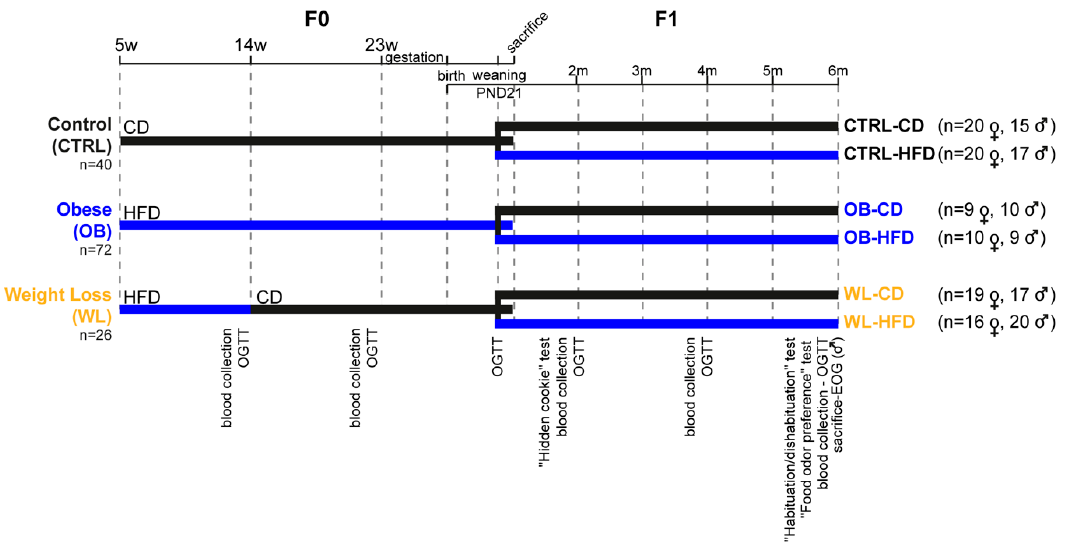
Figure 1. Experimental protocol for studying the effects of maternal periconceptional and postweaning diets on offspring. Female C57BL/6J F0 mice were fed a high-fat (HFD, blue bars) or a control (CD, black bars) diet. After 2 months, a subset of HFD mice was assigned to CD for the next 2 months in order to induce a weight loss (WL group). The remaining mice stayed on HFD to induce a chronic obesity (OB group). Control mice (CTRL) received CD for the 4 months. Females were mated and remained on their experimental diets through pregnancy and lactation. At weaning, male and female offspring were randomly assigned onto CD or HFD: 6 F1 groups were thus obtained. All mice were monitored for body weight and food intake. F0 were sacrificed one week after weaning and F1 were sacrificed at 6 months of age. The schedule of blood collection (leptin and cholesterol measures), metabolic (oral glucose tolerance test, OGTT) and olfactory behavioural tests (“hidden cookie”, “habituation/dishabituation”, “food odour preference” tests and electro-olfactogram, EOG) is indicated. n , individual number per group; w, the week of age; m, the month of age; PND, post-natal day.